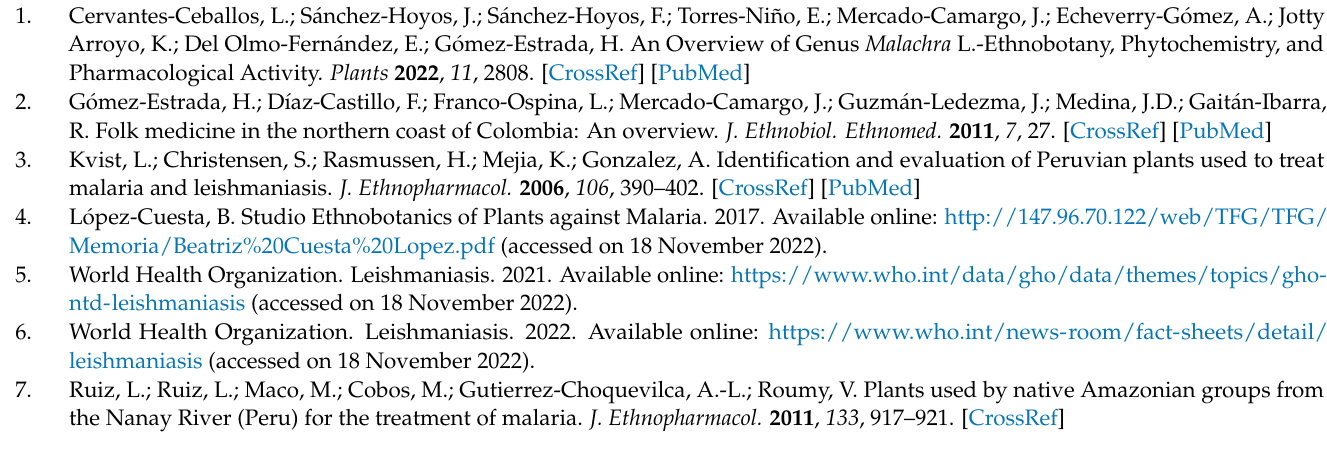
tion of allosteric binding sites of target transketolase (PDB: 1R9J) (Figure S3b), α -Amiryn compound interaction of allosteric binding sites of target arginase (PDB: 4ITY) (Figure S3c), methyl commate A compound interaction of allosteric binding sites of target aldolase (PDB: 1EPX) (Figure S4a), methyl commate A compound interaction of allosteric binding sites of target transketolase (PDB: 1R9J) (Figure S4b), methyl commate A compound interaction of allosteric binding sites of target cysteine peptidases A (PDB: 2C34). (Figure S4c), and identification of amino acid residues in the allosteric site of proteins in L. mexicana selected for docking (Table